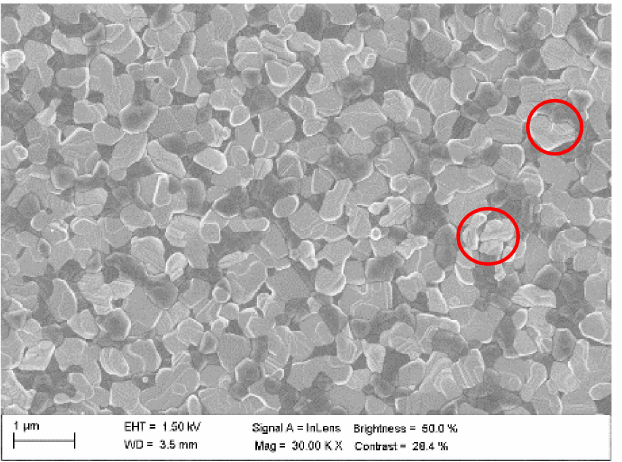
Figure 6. PbI 2 defect passivation of (FAPbI 3 ) 0.97 (MAPbBr 3 ) 0.03 film (symbols depict lighter perovskite domains with greater PbI 2